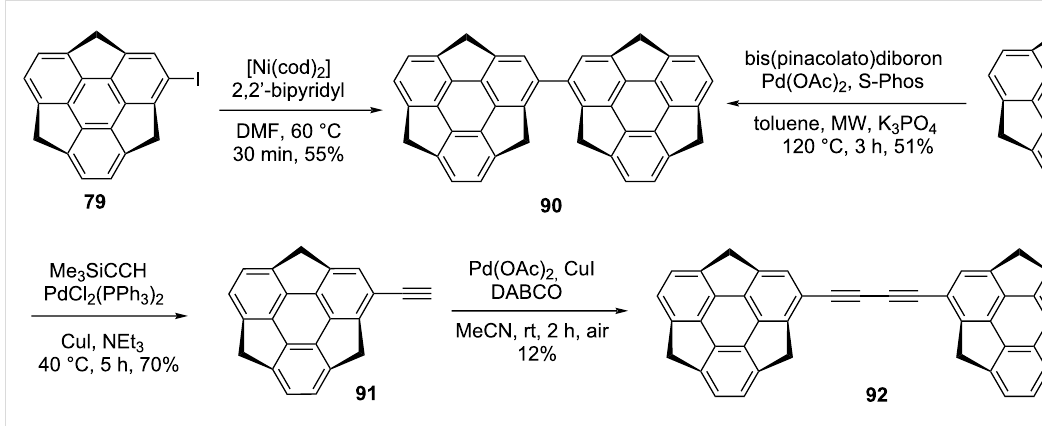
Scheme 21: The dimer 90 and bissumanenyl 92 achieved from halosumannes.